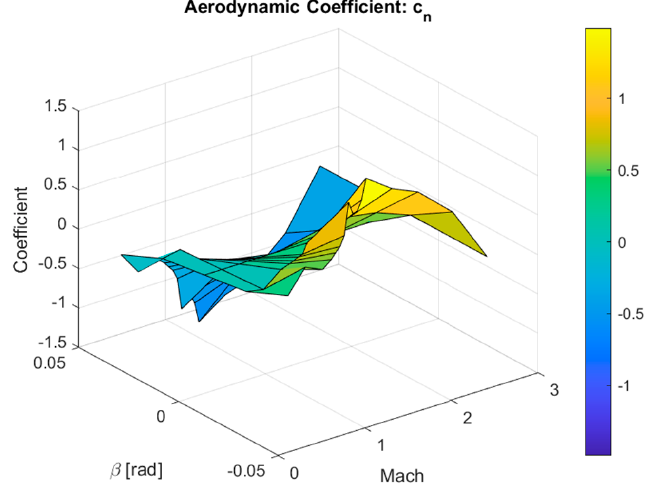
Figure 19. Yaw (forcing) moment coefficient as derived from the sideslip angle and Mach number.